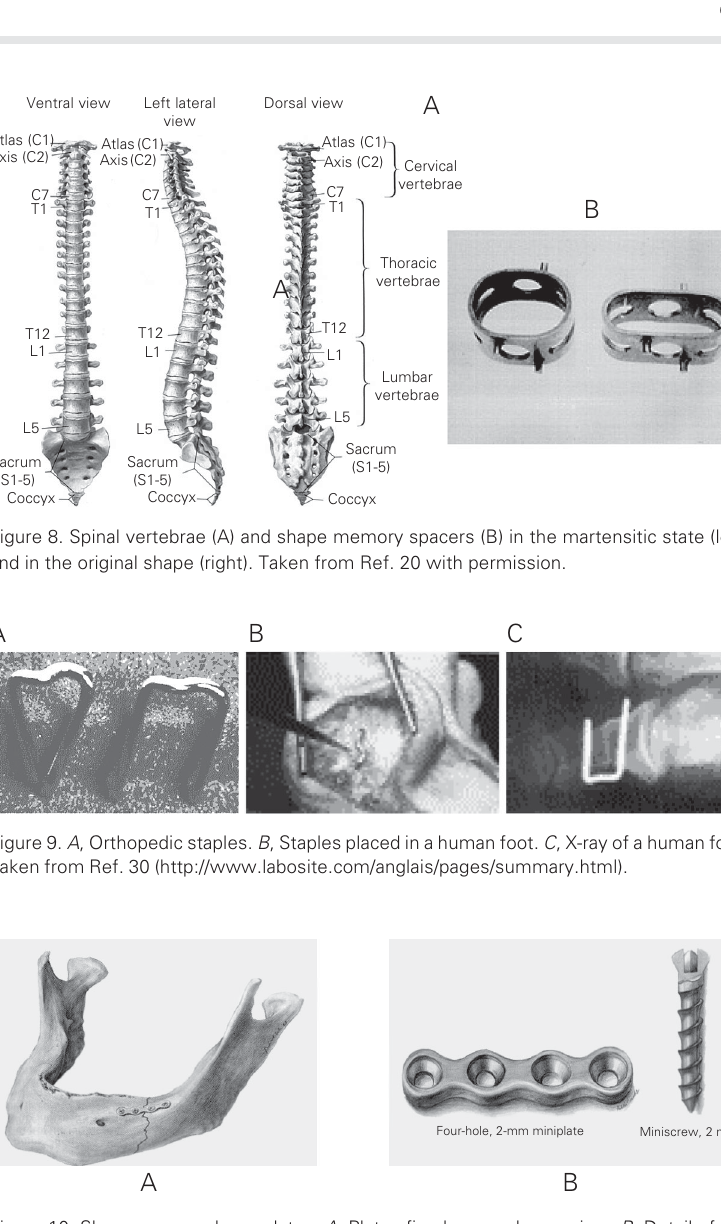
Figure 10. Shape memory bone plates. A , Plates fixed upon a human jaw. B , Detail of the plate and the screw. Taken from Ref. 31 (http://database.cs.ualberta.ca/MEMS/sma_mems).